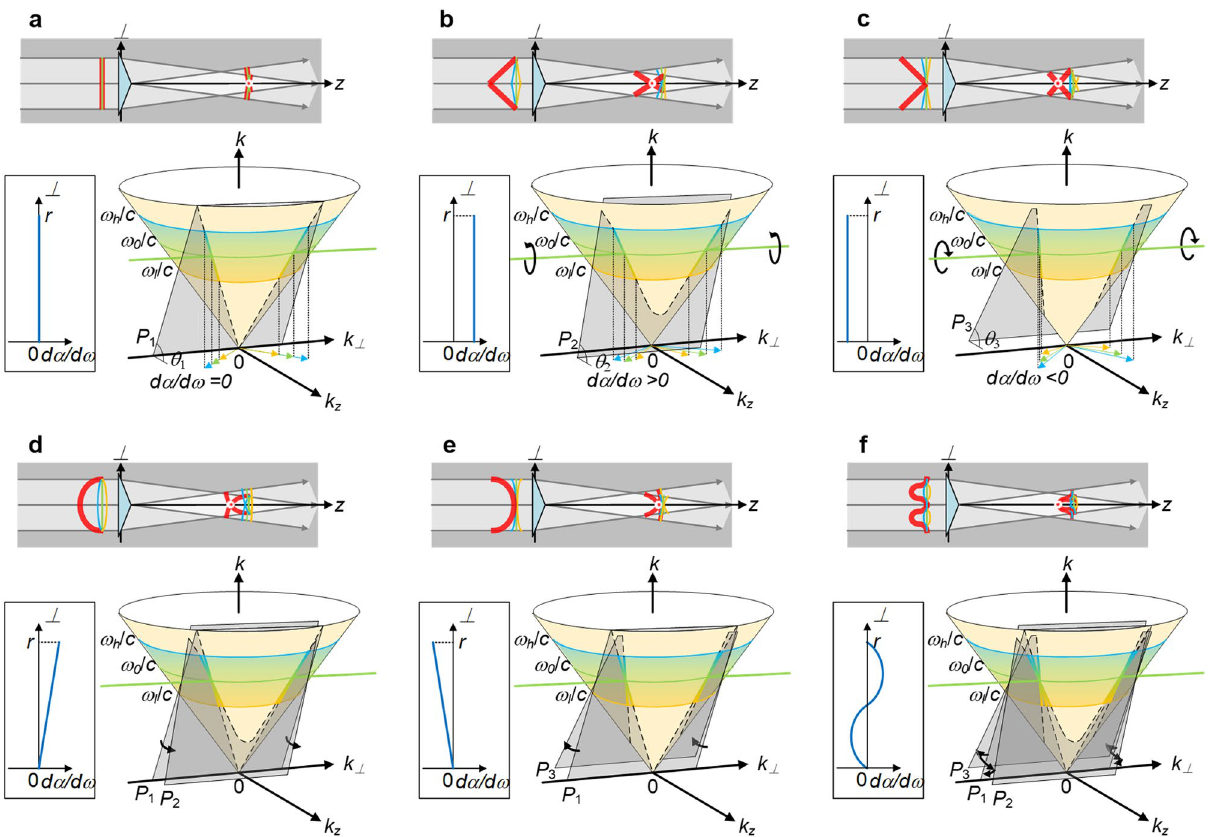
Figure 4. Group-velocity-tunable propagation-invariant optical wave-packet generated by the conical superposition and its spatiotemporal spectrum in the Fourier space. Spatiotemporal spectrum (colored thick line) of propagation-invariant optical wave-packet is a part of intersecting curve between light-cone and spectral plane, and spectral plane is parallel to k ⊥ -axis and passes through green thick straight line ( k z , k ) = ( ω 0 / c ⋅ cos α 0 , ω 0 / c ). Vertex is defined as intersecting point between spatiotemporal spectrum’s locus and plane k ⊥ = 0 at positive direction of k z -axis. ( a ) Without pulse-front deformation, no angular dispersion across beam aperture dα / dω = 0, vertex is at origin, and spectral plane is P 1 with tilt angle θ 1 ; ( b ) with concave-conical pulse-front deformation, constant positive angular dispersion across beam aperture dα / dω > 0, vertex is k v < ω l / c , and spectral plane is P 2 with tilt angle θ 2 ; ( c ) with convex-conical pulse-front deformation, constant negative angular dispersion across beam aperture dα / dω < 0, vertex is k v > ω h / c , and spectral plane is P 3 with tilt angle θ 3 ; ( d ) with concave-spherical pulse-front deformation, from beam center to upper beam edge, angular dispersion dα / dω increases linearly from zero to maximum, and instantaneous spectral plane is rotating counterclockwise from P 1 to P 2 ; ( e ) with convex-spherical pulse-front deformation, from beam center to upper beam edge, angular dispersion dα / dω decreases linearly from zero to minimum, and instantaneous spectral plane is rotating clockwise from P 1 to P 3 ; and ( f ) with cosine-function-like pulse-front deformation, from beam center to upper beam edge, angular dispersion dα / dω decreases from zero to minimum, increases to zero and then maximum, and decreases to zero eventually, and instantaneous spectral plane is rotating clockwise from P 1 to P 3 , counterclockwise to P 1 and then P 2 , and clockwise to P 1 eventually. Tilt angles are θ 3 < θ 1 < θ 2 ; k v is wavenumber of vertex; ω l , ω 0 , and ω h are the lowest, center and highest angular frequencies of pulse; and r is beam radius. Figure generated by Microsoft® Visio® 2013 50 By differentiating two sides of Eq. (12) about the center angular frequency ω 0 , the conical-angle dispersion is given by